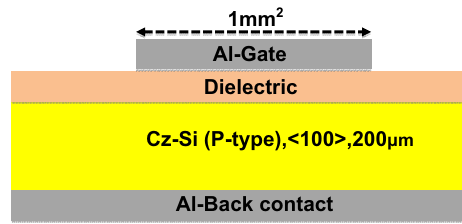
Fig. 1. Schematic of the metal insulator semiconductor (MIS)